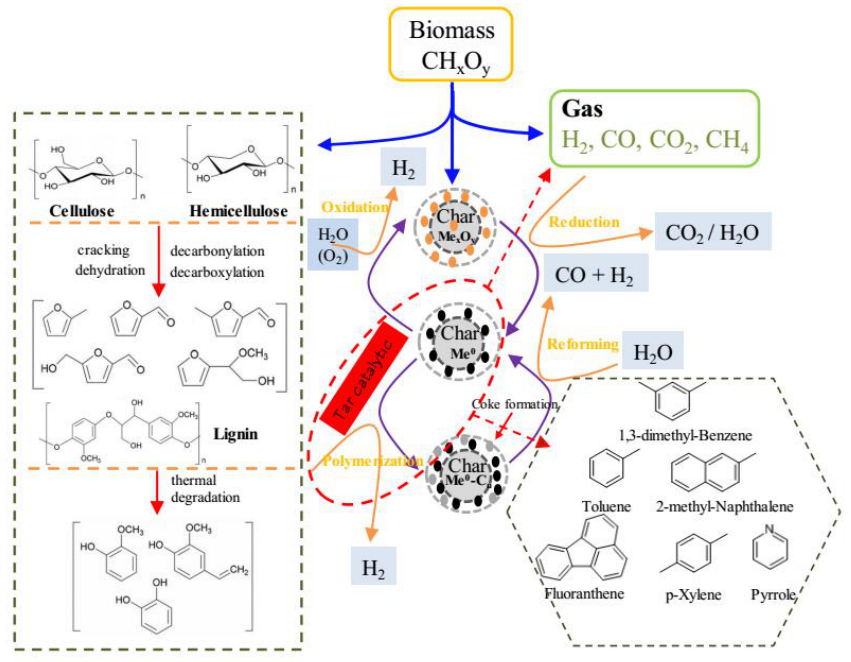
Figure 6. Proposed reaction pathway for ex situ catalytic pyrolysis of biomass.